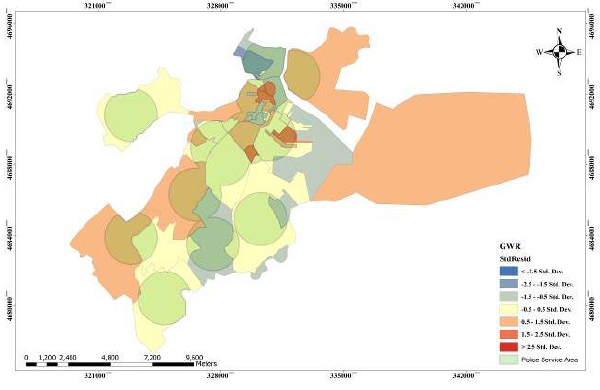
Figure 8. The compared result of GWR and Police station coverage